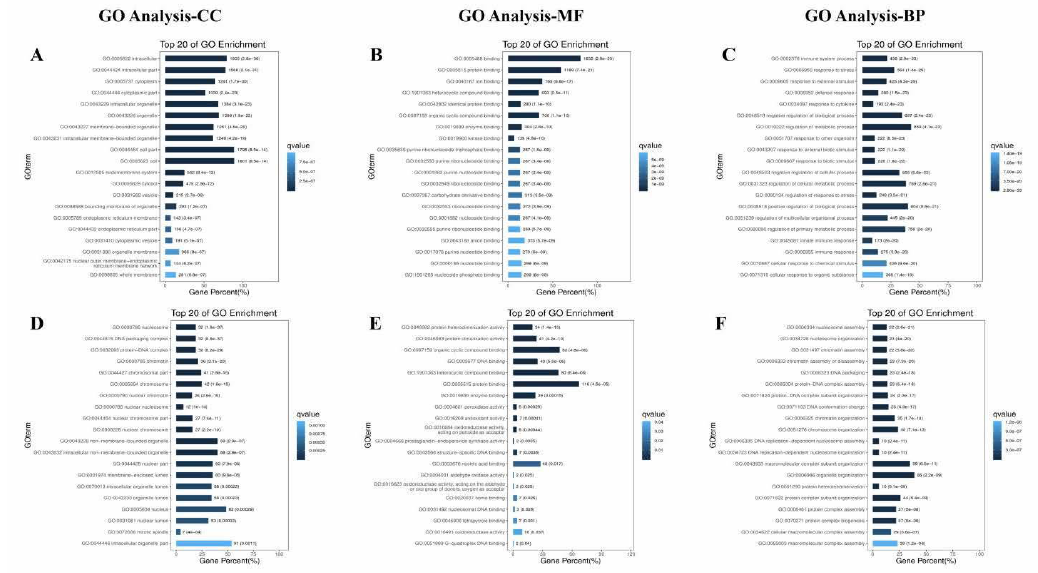
Figure 10. Gene Ontology term analysis of differentially expressed mRNA. C group and CV group: Gene Ontology annotation of mRNA in cellular components ( A ), molecular functions ( B ), and biological process ( C ). CV group and CVM group: Gene Ontology annotation of mRNA in cellular components ( D ), molecular functions ( E ), and biological process ( F ). GO, Gene Ontology; CC, cellular component; MF, molecular function; BP, biological process.